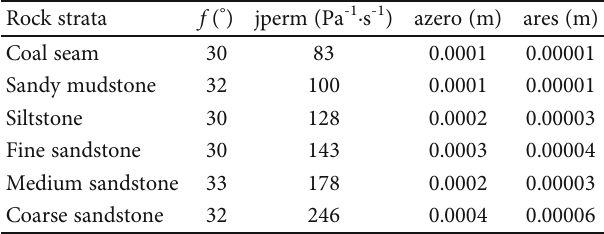
Table 2: The percolation mechanical parameters of joints. Rock